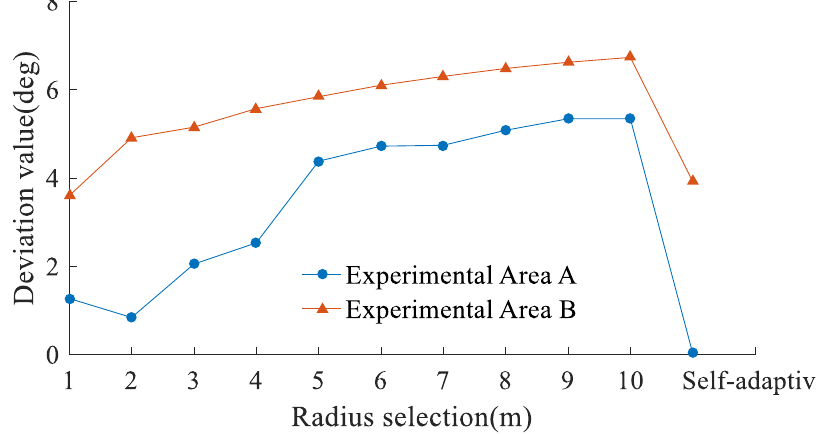
Figure 19. The deviation between the values of the incidence angle correction and the surface probability extremum slopes in the two experimental areas.